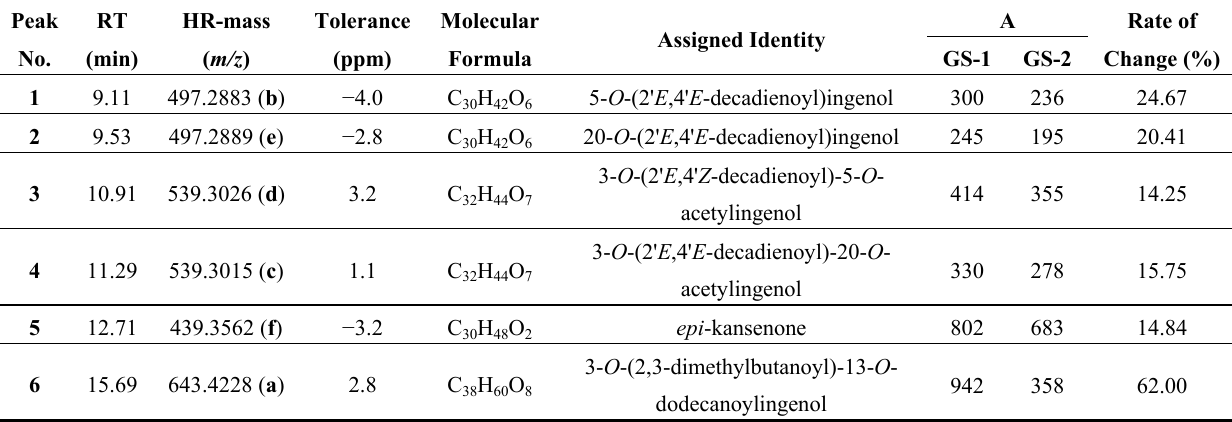
Table 1. The identification and comparison of the most differentiating components between GS-1 and